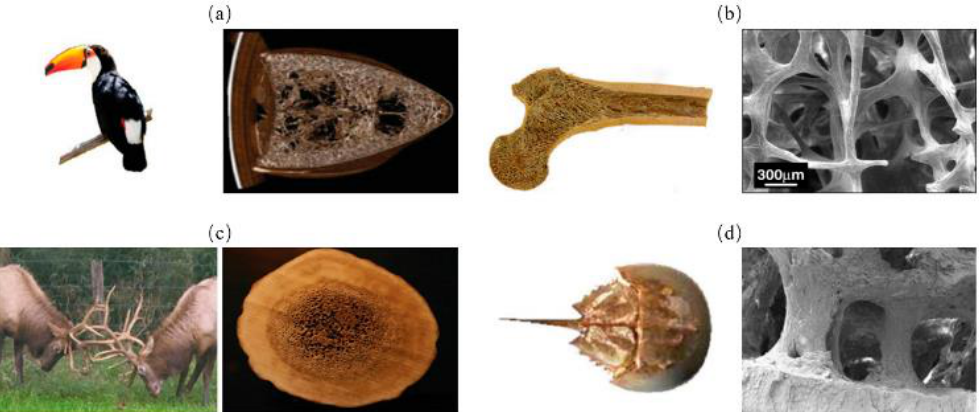
Figure 11. Schematic diagram of the sandwich model with minimal surface structure core.